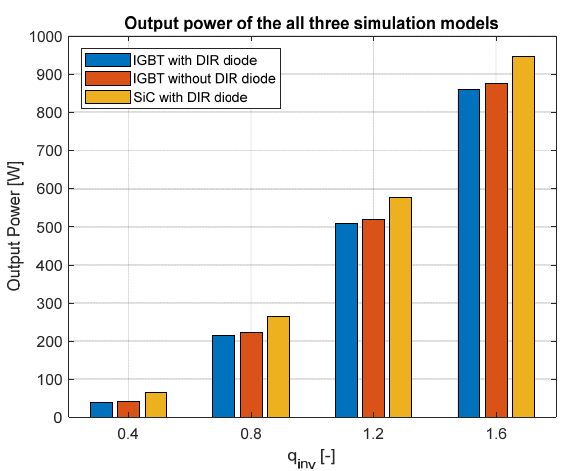
Figure 9. Output powers of the simulation models.